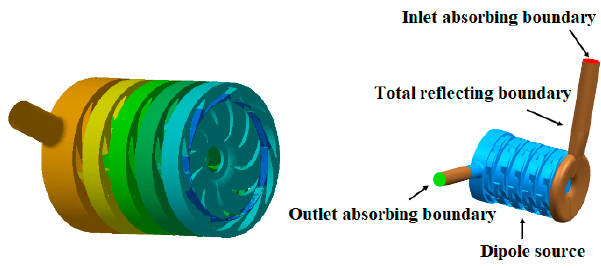
Figure 9. Dipole source and acoustic boundaries.